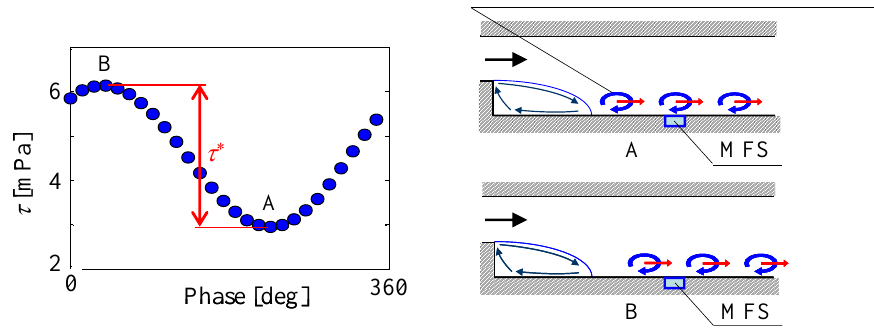
Fig. 4 Wall shear stress affected by transverse vortex